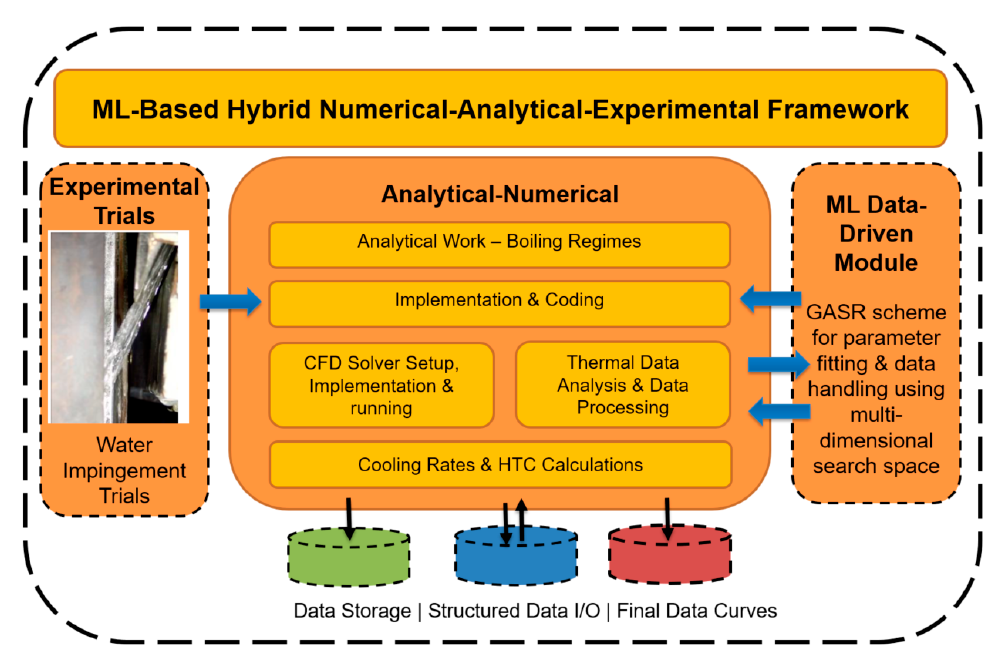
Figure 2. Hybrid numerical-analytical-experimental framework for cooling process and HTC modelling.